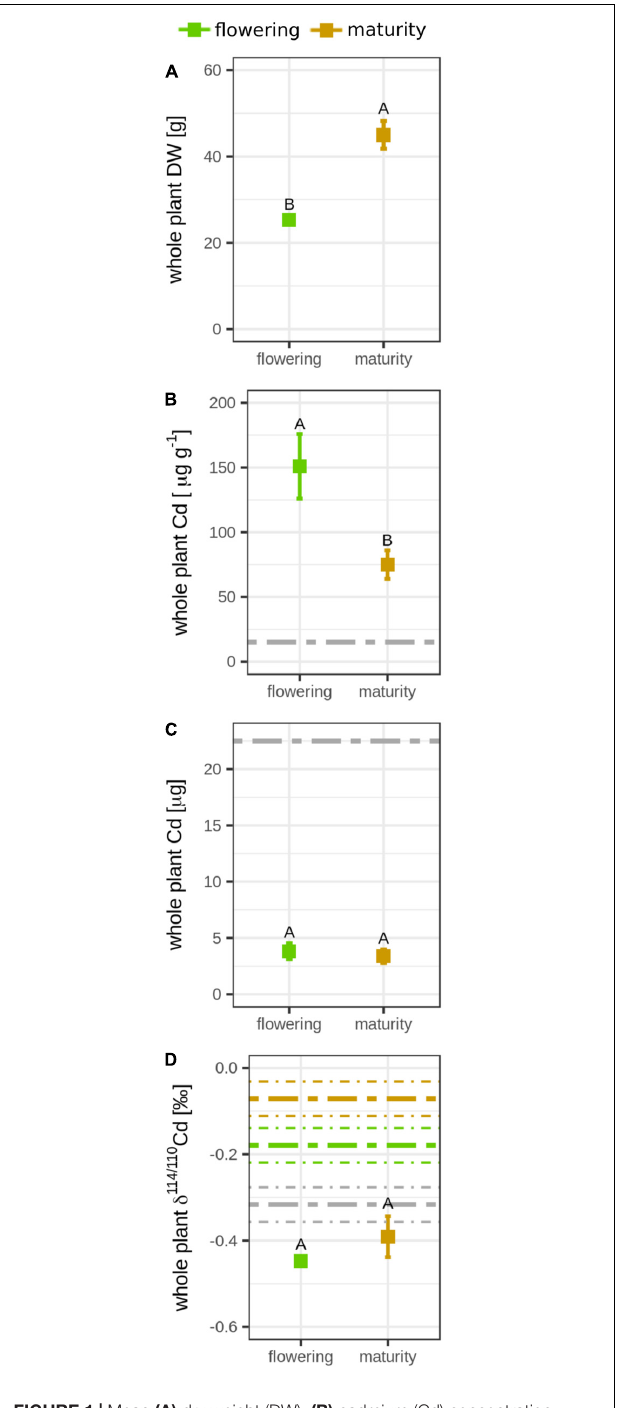
FIGURE 1 | Mean (A) dry weight (DW), (B) cadmium (Cd) concentration, (C) Cd mass, and (D) Cd isotope ratio of the whole rice plants that were harvested at flowering and maturity. Error bars for plants represent the standard deviation of n = 4 experimental replicates. Letters denote significant differences of the mean that were determined by either (B,C) a Welch’s t- test or (A,D) a Wilcoxon rank sum test. Dashed lines represent soil data: gray, bulk soil; green and brown, Ca(NO 3 ) 2 extractable Cd (2 * standard deviation of the mean of n = 2 experimental replicates). Data from the flowering growth stage was published previously (Wiggenhauser et al.,